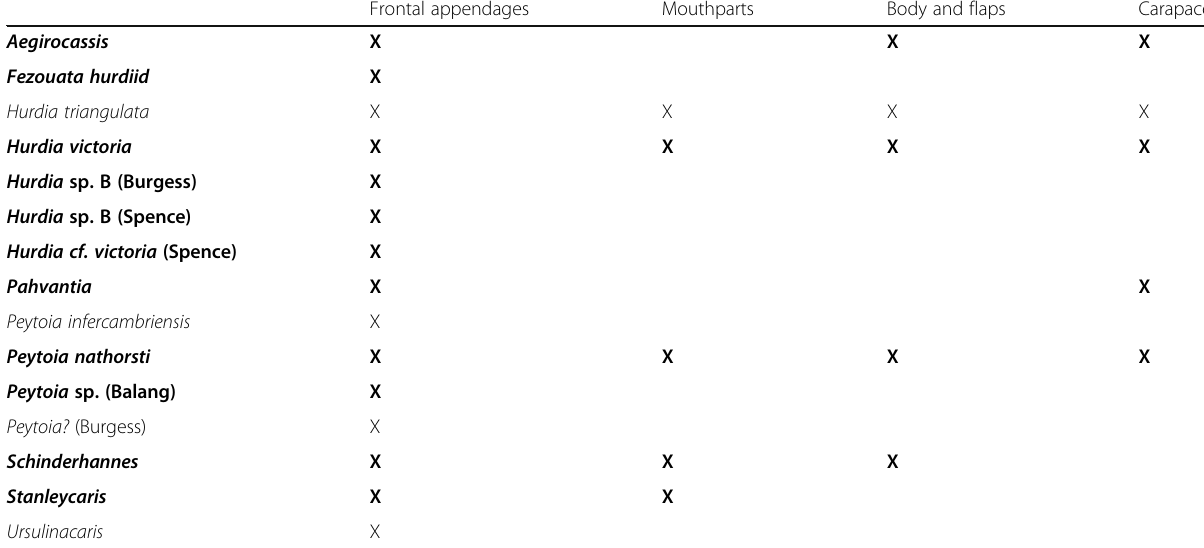
five elongate endite-bearing podomeres in the distal ar- ticulated region, and the presence of auxiliary spines on the distal margin of endites only. This new radiodont, Ursulinacaris , along with additional future descriptions of new hurdiid taxa, will provide crucial data for resolv- ing the sequence of character acquisitions in the radio- dont frontal appendage, as well as inter- and intrafamily relationships in future phylogenetic analyses of the